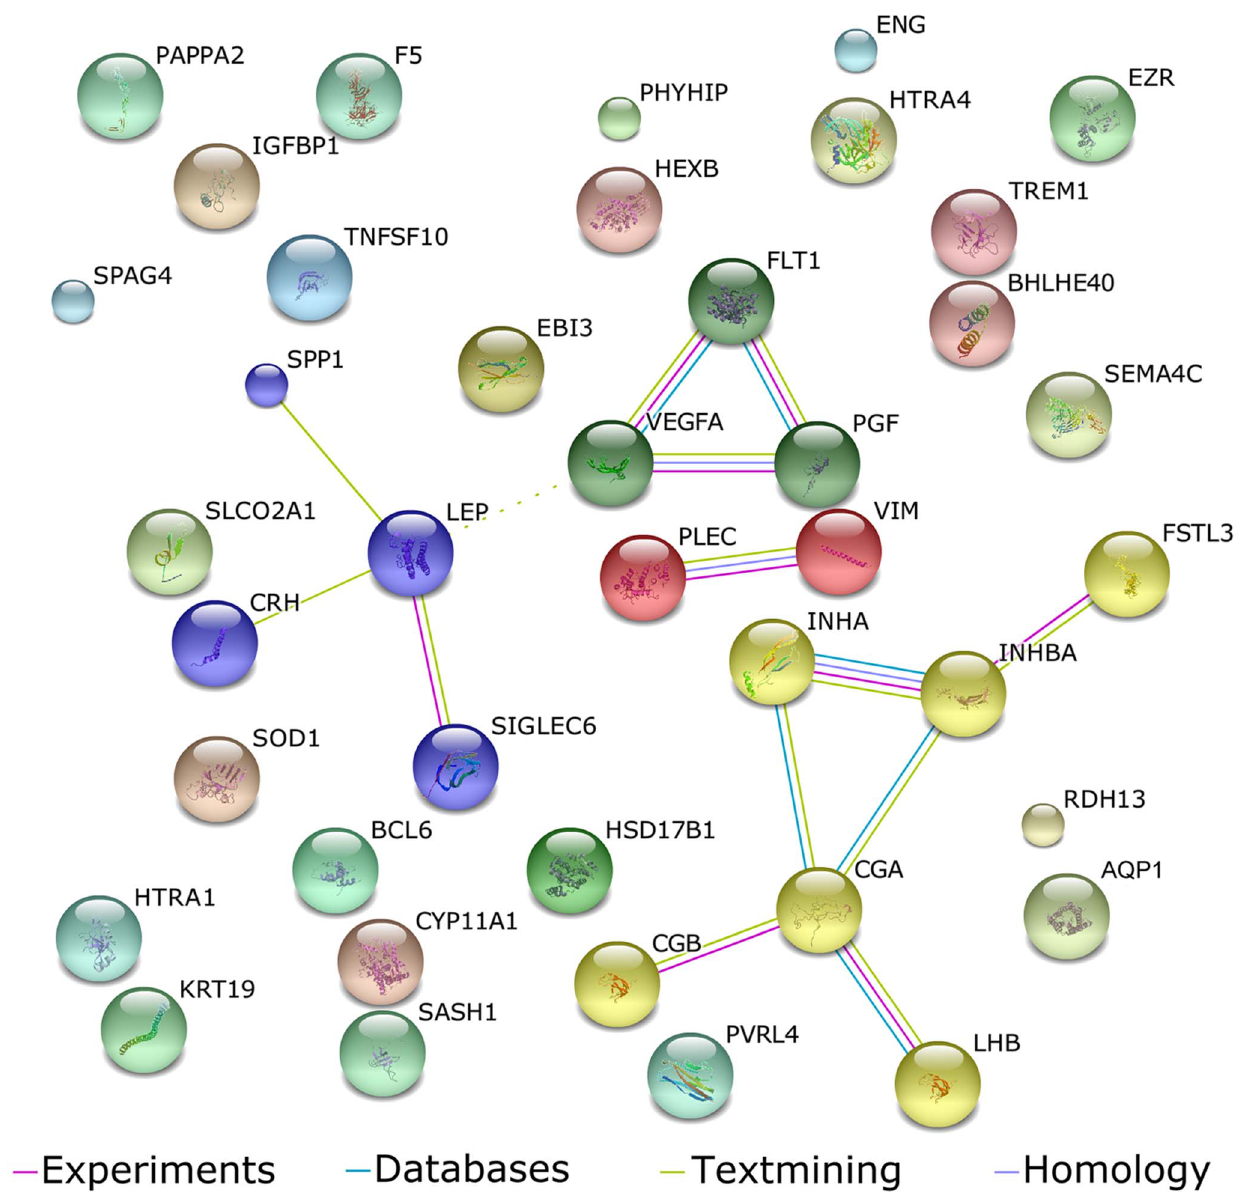
Figure 2. Functional networks within the meta-signature. To build a functional network map the 40 meta-signature genes were analyzed using STRING software. Interactions are based on information from experimental and curated protein databases, and text mining with a high confidence setting of 0.8; the resulting networks were clustered using Markov clustering.